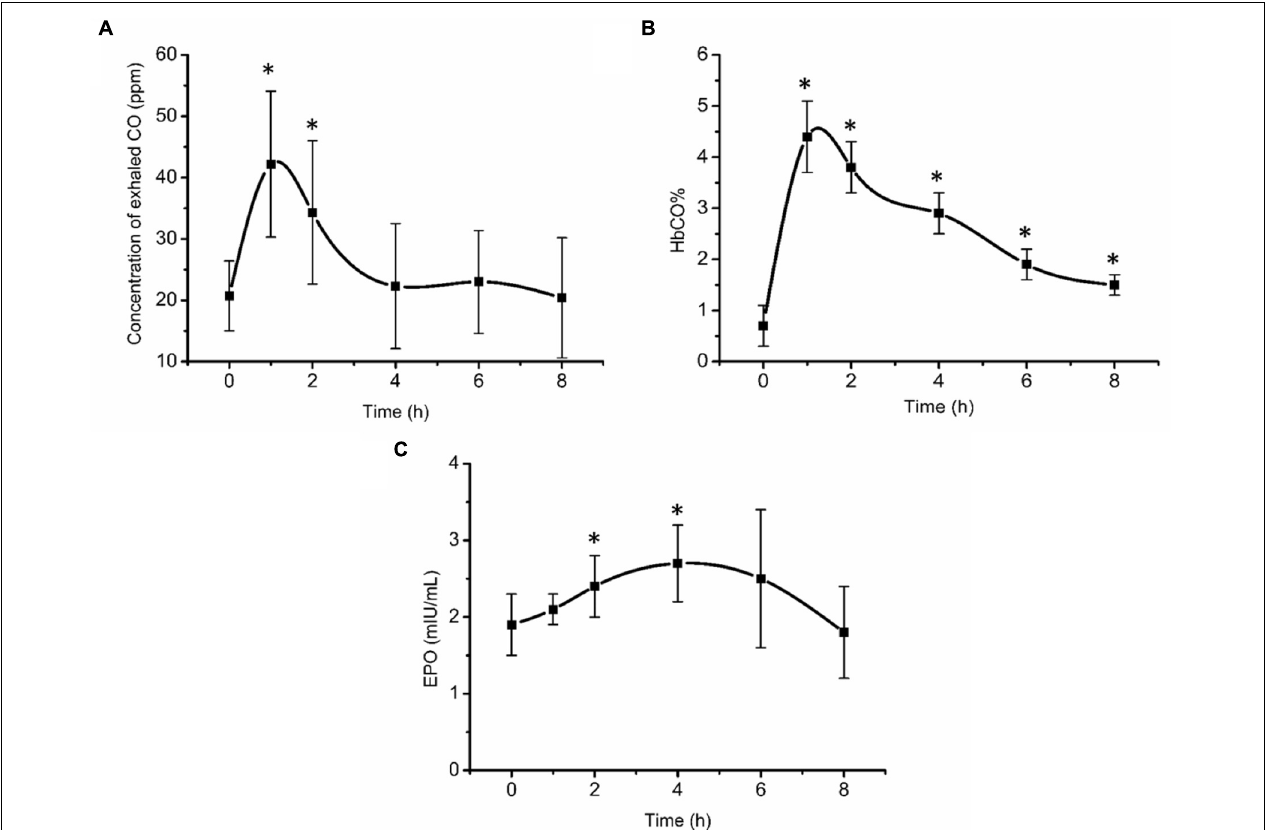
FIGURE 2 | Exhaled CO concentration (A) , blood HbCO% (B) , and EPO concentration (C) after acute inhalation of CO. ∗ Compared to baseline value P < 0.05. The HbCO% and EPO are percentage of carboxy-hemoglobin and erythropoietin hormone, respectively.